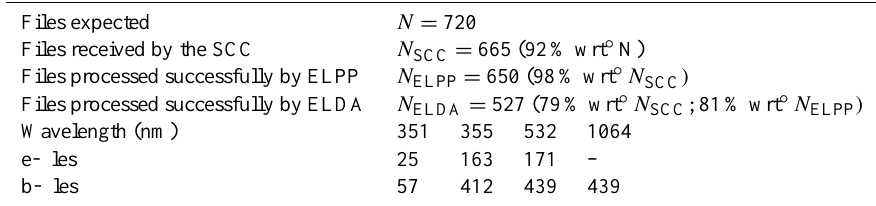
Table 3. Number of files at the different stages of the exercise and finally inverted by the